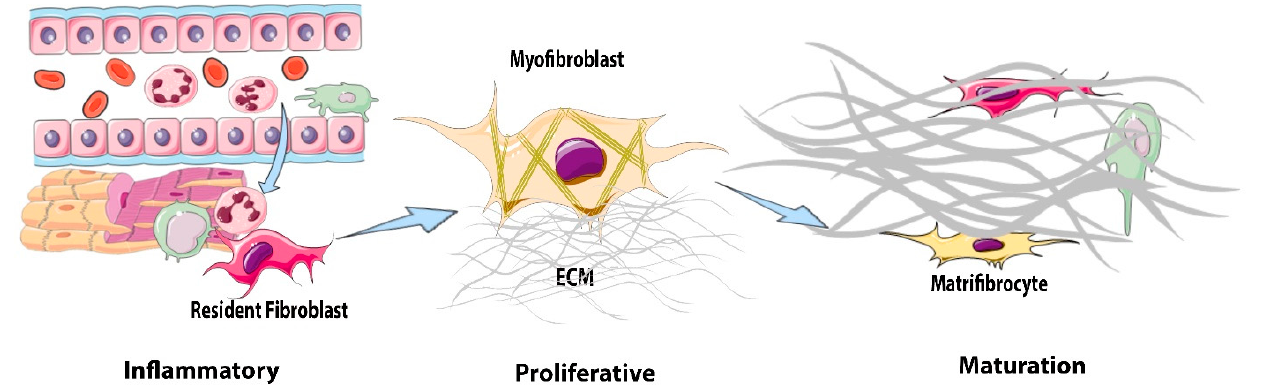
Figure 1. Phenotypic transitions of cardiac fibroblasts in the infarcted myocardium. During the inflammatory phase of infarct healing, necrotic cardiomyocytes release damage-associated molecular patterns that activate a pro-inflammatory, matrix-degrading phenotype in cardiac fibroblasts and contribute to the recruitment of leukocytes to the injury site. The clearance of dead cardiomyocytes stimulates anti-inflammatory signals, leading to the transition to the proliferative phase of infarct healing. During the proliferative phase of infarct healing, resident cardiac fibroblasts proliferate and undergo myofibroblast conversion, incorporating α -smooth muscle actin ( α -SMA) into cytoskeletal stress fibers. Myofibroblasts are the main matrix-synthetic cells in the infarcted heart and produce both structural and matricellular extracellular matrix (ECM) proteins. During scar maturation, fibroblasts exhibit the disassembly of stress fibers and transition to matrifibrocytes, specialized cells that may play a role in scar maintenance.